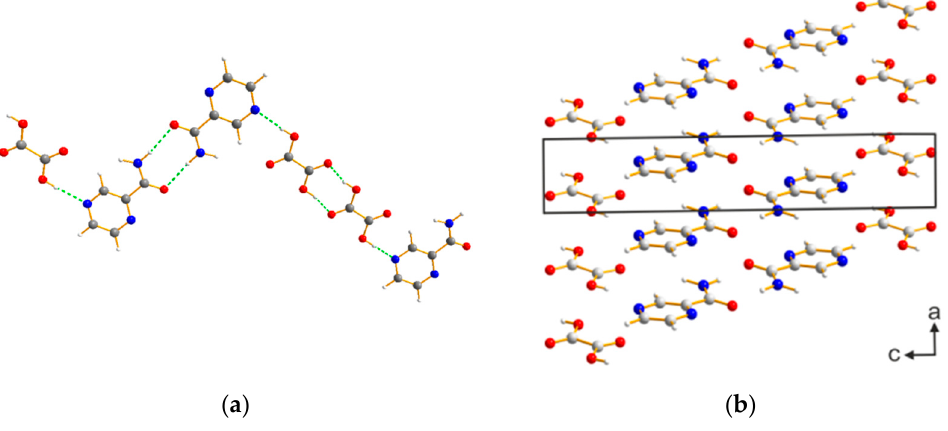
Figure 2. ( a ) Hydrogen bond interactions indicated by green dashed lines ( b ) structure of the PZA:OA (1:1) cocrystal, view along the b-axis.